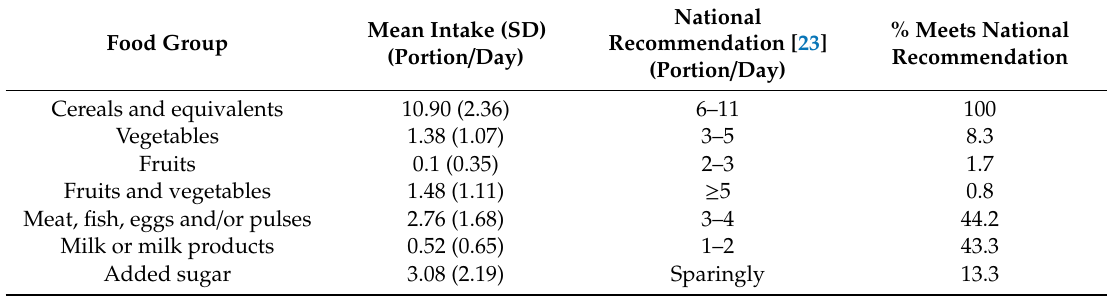
Table 4. Comparison of mean food intake by food groups of the study population with the national